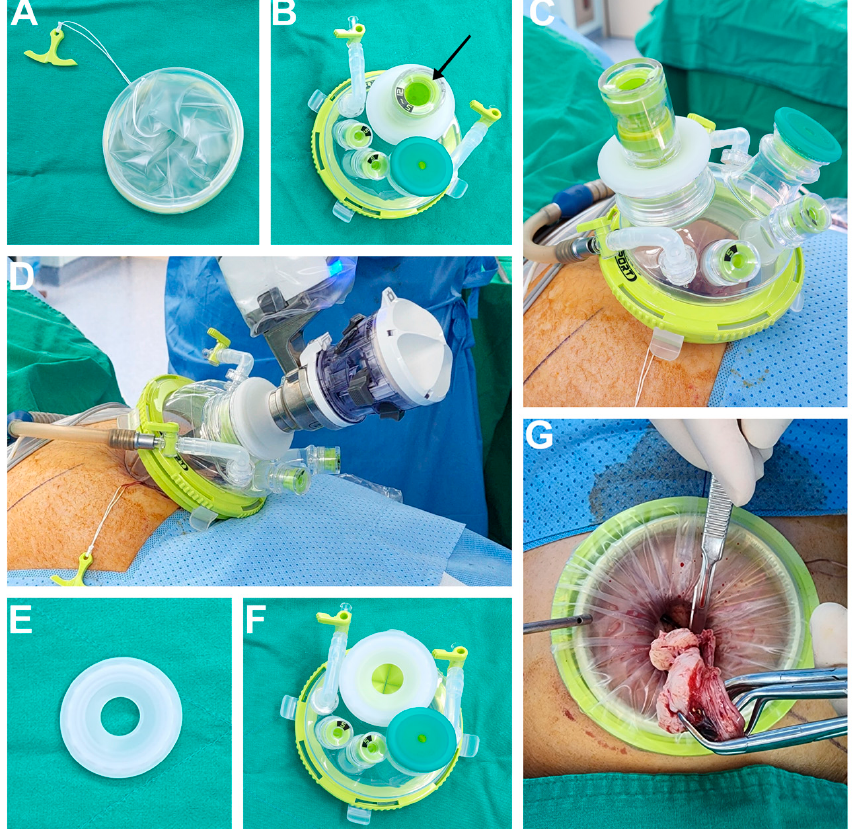
Figure 1. ( A ) The wound retractor part of the Uni-port. ( B ) The cap part of the Uni-port with a laparoscopic port cap (black arrow) and four additional ports. ( C ) The assembled Uni-port for laparoscopic surgery. The CO 2 line is connected, and abdominal cavity is inflated. ( D ) da Vinci ® SP robot docking is completed. For robotic surgery, the port cap of the Uni-port is replaced, and the SP trocar is inserted. The CO 2 line is connected, and the abdominal cavity is inflated. ( E ) The special port cap of the Uni-port for da Vinci ® SP robot trocar. ( F ) The cap part of the Uni-port for the da Vinci ® SP robot surgery system. The port cap indicated by the black arrow in Figure 1B has been replaced with the port cap for the da Vinci ® SP robot trocar. ( G ) After the resected myoma is placed in an endopouch, it is pulled by hand, by holding it with a tenaculum forceps or towel clip. The inlet part of the endopouch is covered and fixed to the retractor part of the Uni-port. Subsequently, manual morcellation using scalpel is